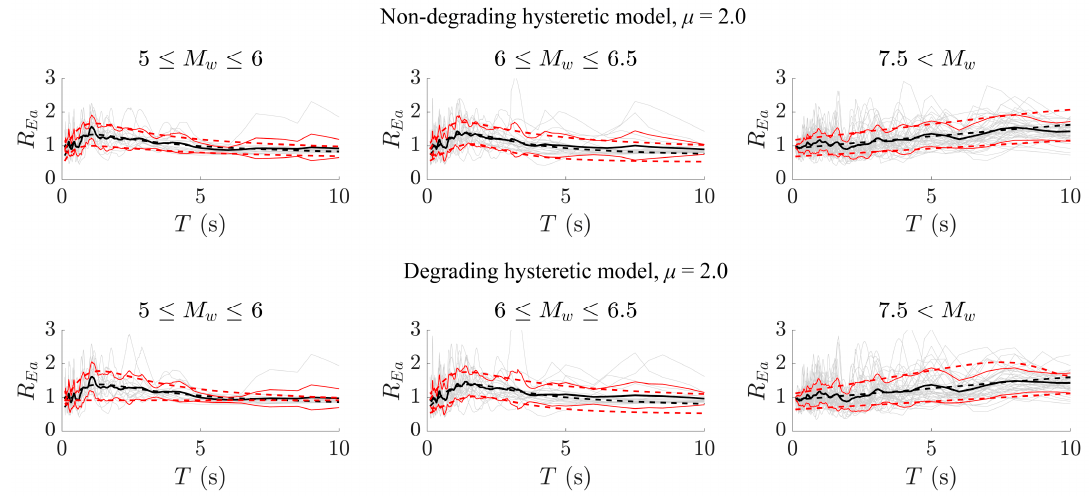
Figure 11. Comparison between calculated absolute input energy reduction factor R Ea spectra (mean and mean plus/minus one standard deviation) and proposed approximation (thin solid line: single spectrum; thick solid line: calculated spectrum; thick dashed line: proposed approximation).